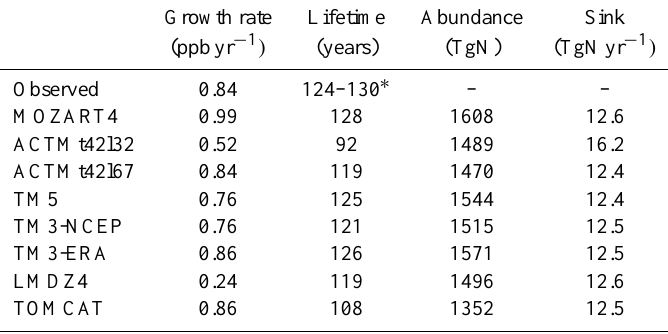
Table 7. Annual mean (2006–2009) tropospheric growth rate, atmospheric lifetime, atmospheric abundance (up to 50hPa) and global total sink of N 2 O.